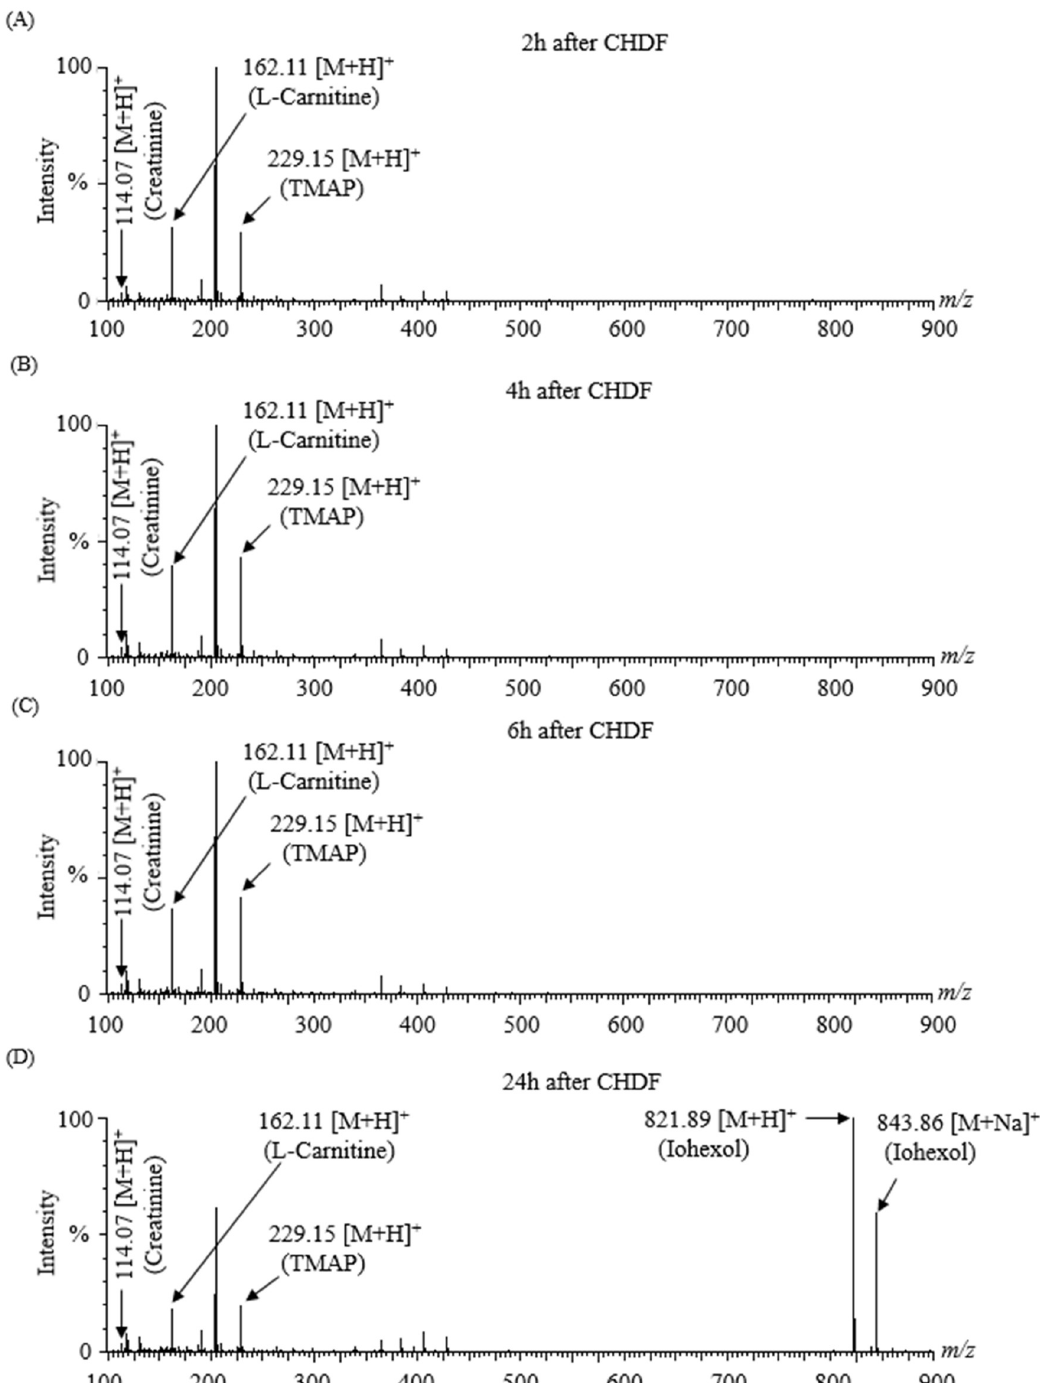
Fig 2. Detection of iohexol (an ICM) and three endogenous metabolites in untreated spent hemodialysates of patient #1 by Synapt G2 Q-TOF MS. The peaks corresponding to creatinine, L-carnitine, and TMAP were detected in samples obtained (A) 2h, (B) 4h, and (C) 6h after the start of CHDF. (D) Three endogenous metabolites along with the iohexol ( m/z 821.89 and m/z 843.86) were detected in the sample collected 24h after the start of CHDF (iohexol was injected 6h after the start of CHDF).